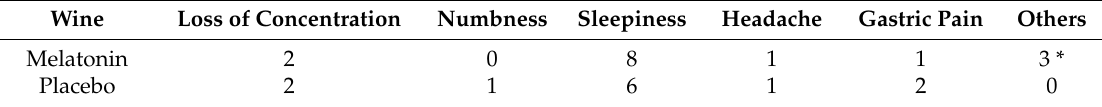
Table 2. Side effects and adverse events reported by the volunteers ( n =